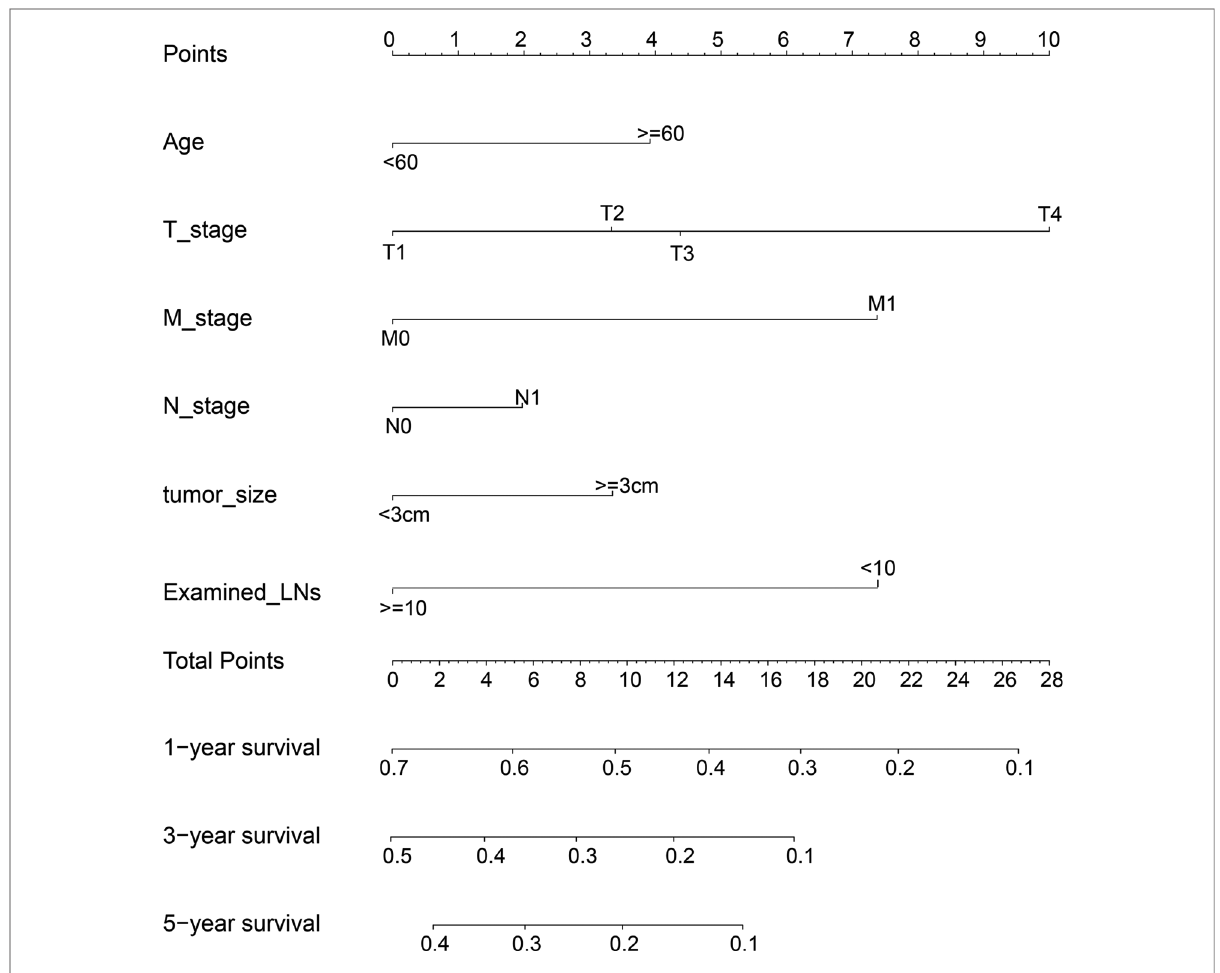
FIGURE 5 Model predicted 1-, 3- and 5-year CSS based on the number of ELNs.